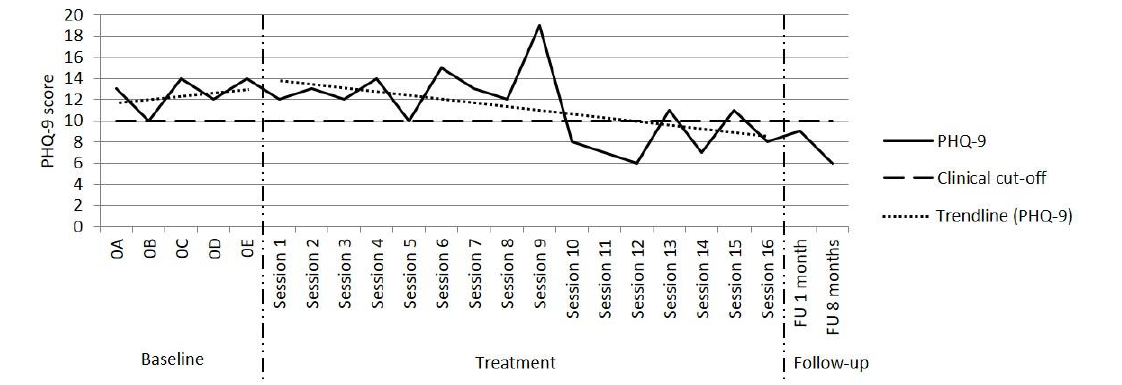
Figure 1: Giovanni’s weekly depressive (PHQ-9)